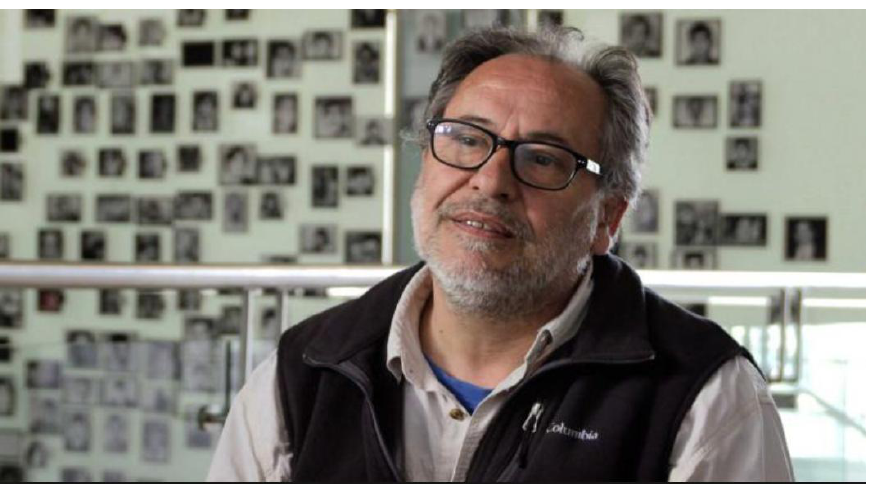
Figure 4. Jorge Lübbert, pictured; frame from El color del camaleón (Lübbert 2017). Picture courtesy of Andrés Lübbert.